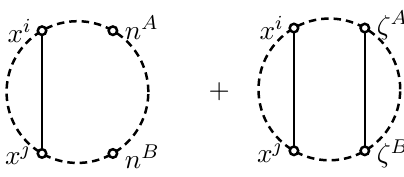
Figure 5 . Leading order disconnected contributions to h x i x j Y A Y B i